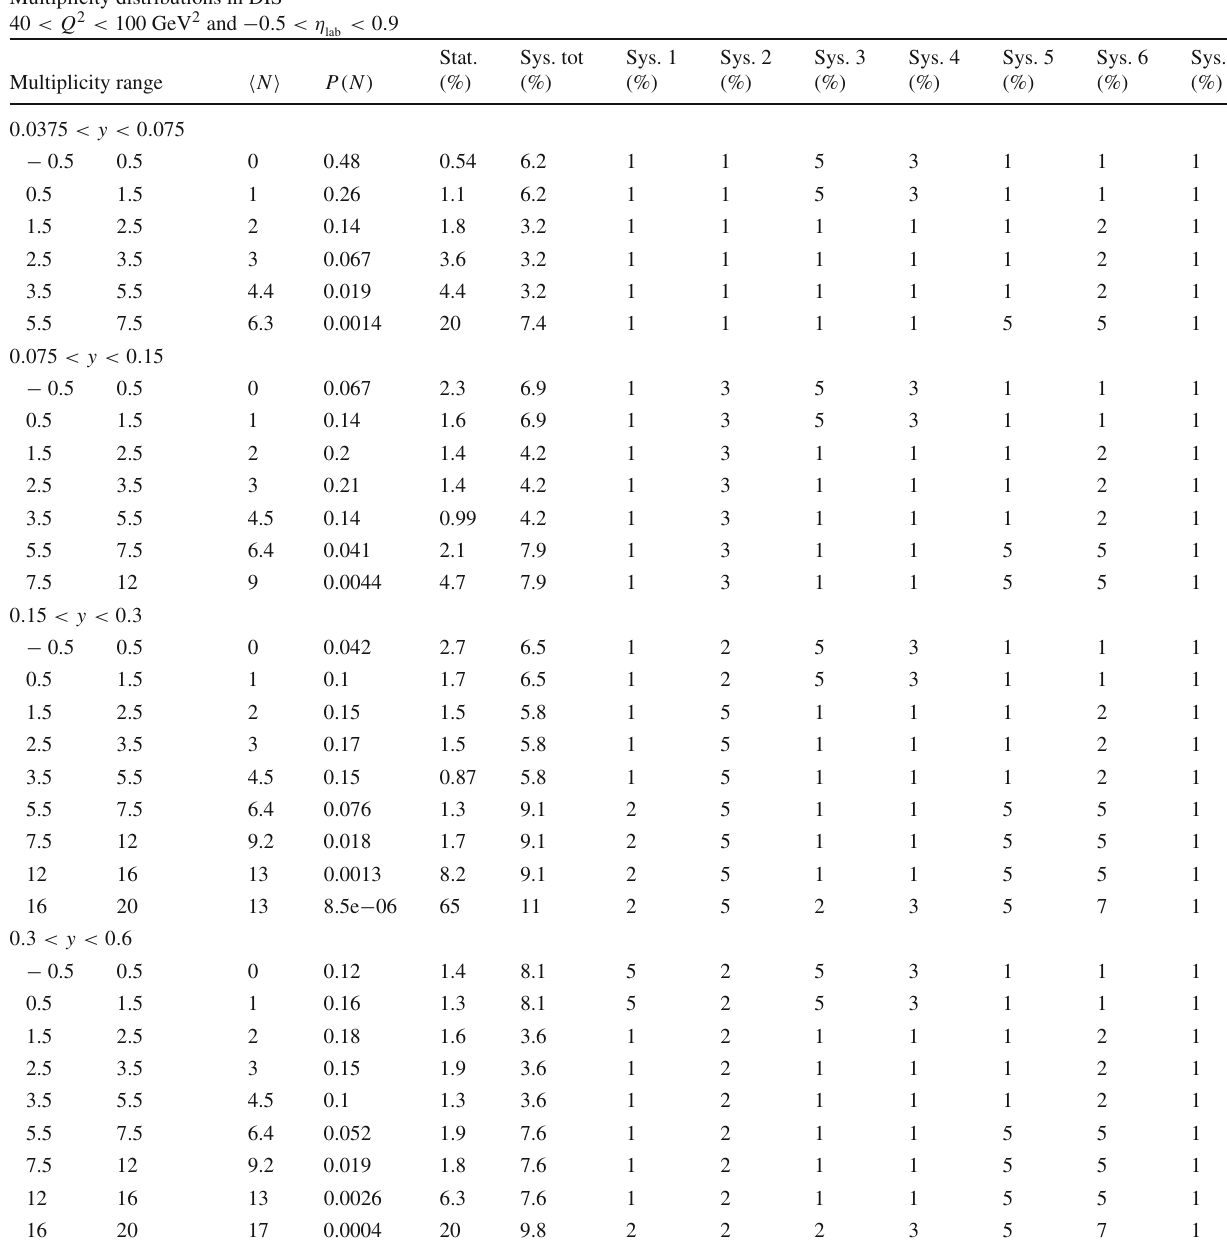
Table 23 Charged particle multiplicity distributions P ( N ) measured √ s = 319GeV with in the ranges of photon virtual- in ep DIS at ity 40 < Q 2 < 100 GeV 2 and charged particle pseudorapidity range Multiplicity distributions in DIS < 0 . 40 < Q 2 < 100 GeV 2 and − 0 . 5 < η lab